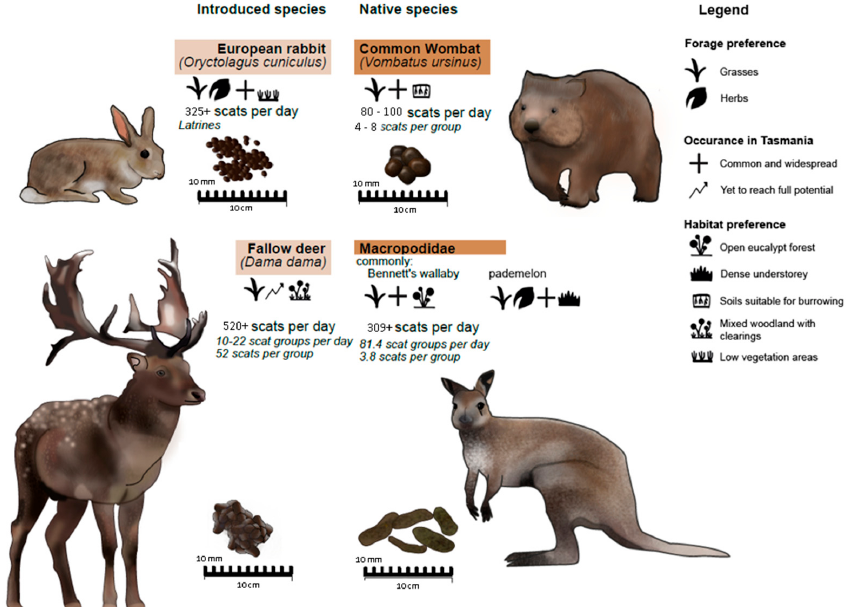
Figure 3. Approximate defecation rate and habits for the four herbivore groups in this study. In- cluded here are forage preferences, population occurrence, and habitat preference in